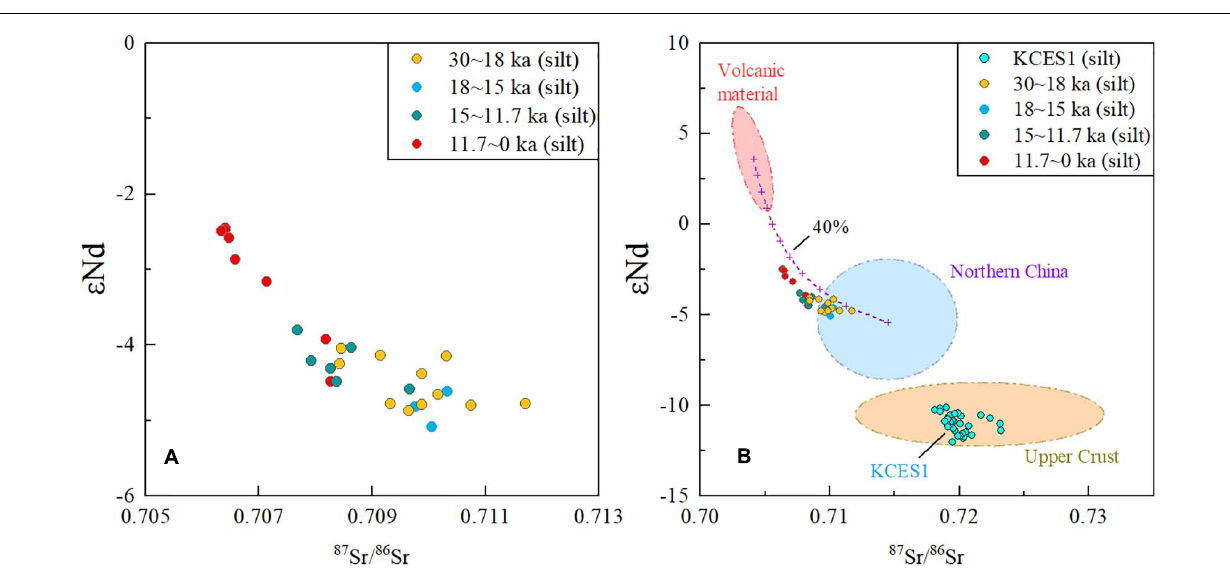
FIGURE 9 | Discrimination plots of ε Nd v.s. 87 Sr/ 86 Sr in core LV53-18-2 sediments (A) , in comparison with potential sources (B) . The curve represents the proportion of the Japan Arc (Morris and Kagami, 1989) end-member ( ε Nd = 3.59, 87 Sr/ 86 Sr = 0.704142) mixing with the Mongolian Gobi (Zhao et al., 2015)-Northeast China desert (Chen et al., 2007) end-member ( ε Nd = − 5.4, 87 Sr/ 86 Sr =